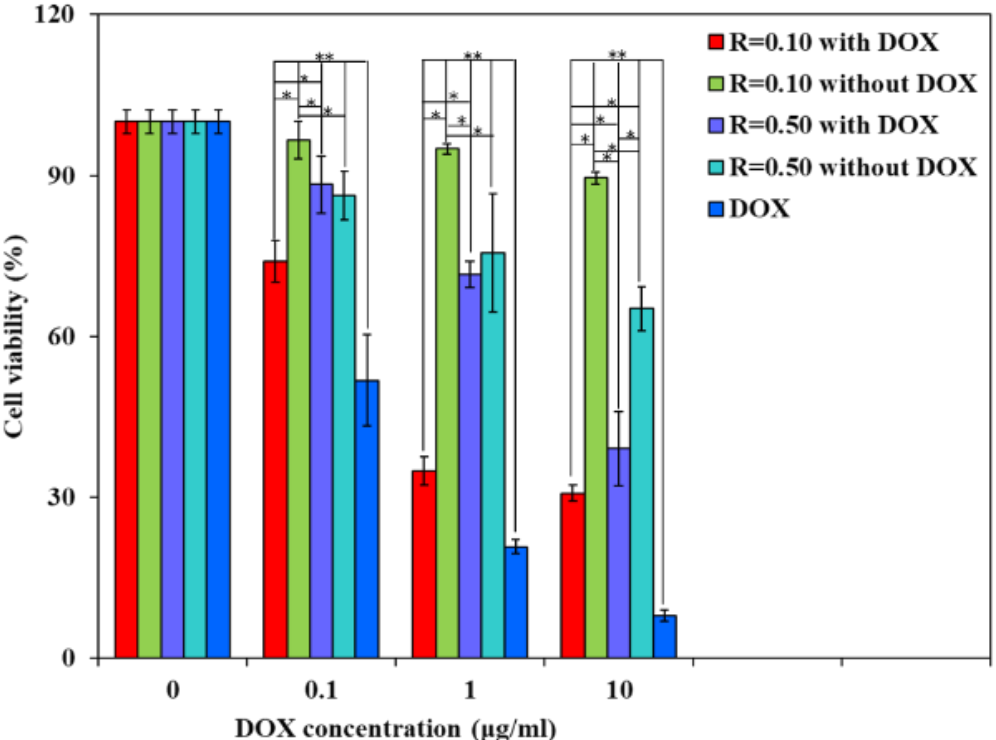
Figure 8. Cell viability of SKBR3 cells after 72 h exposed to DOX-loaded nanoparticles, corresponding empty nanoparticles, or free DOX. There was a significant difference between different nanoparticles with DOX and without DOX (* p < 0.05). Furthermore, there was a significant difference between nanoparticles and free DOX (** p < 0.05).